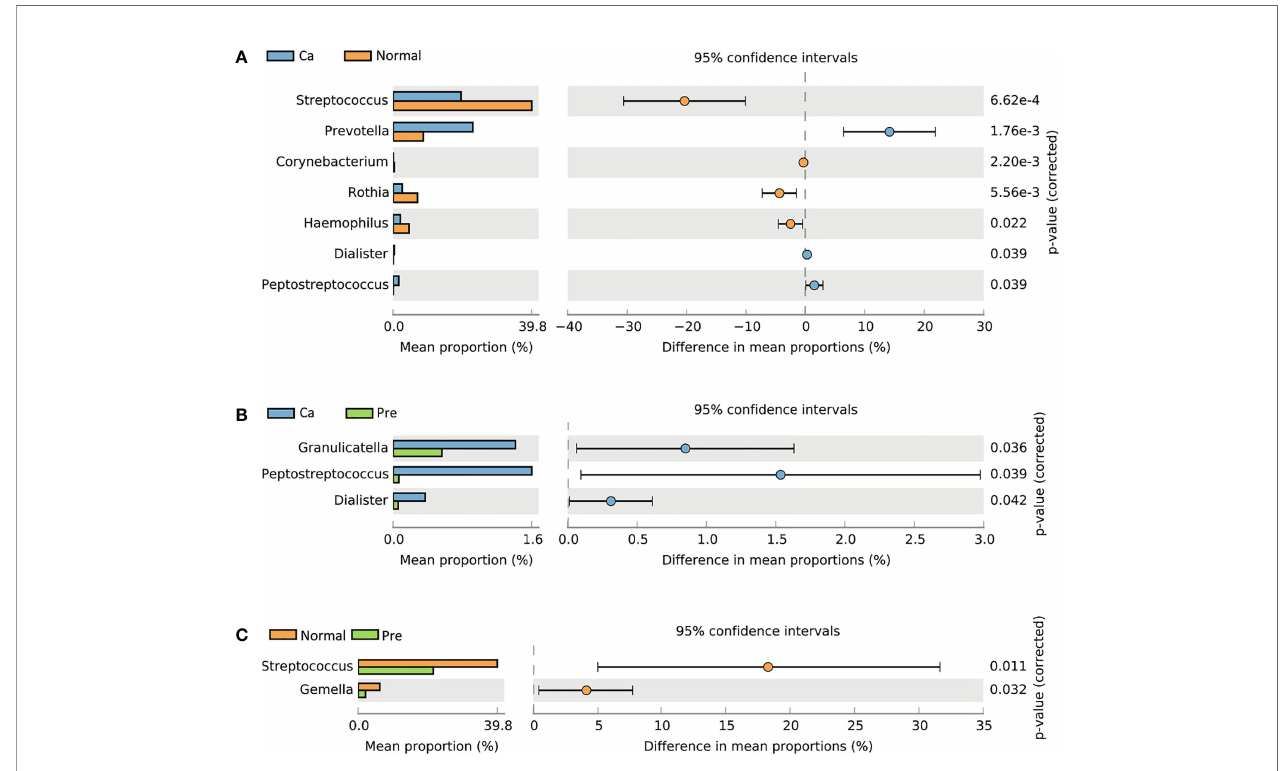
FIGURE 2 | Comparison of taxonomic pro fi les at the genus level among the three groups showed signi fi cant differences in richness between two groups (P < 0.05, calculated using STAMP). (A) Difference between the oral cancer group and normal group. (B) Difference between the oral cancer group and precancerous lesion group. (C) Difference between the normal group and precancerous lesion